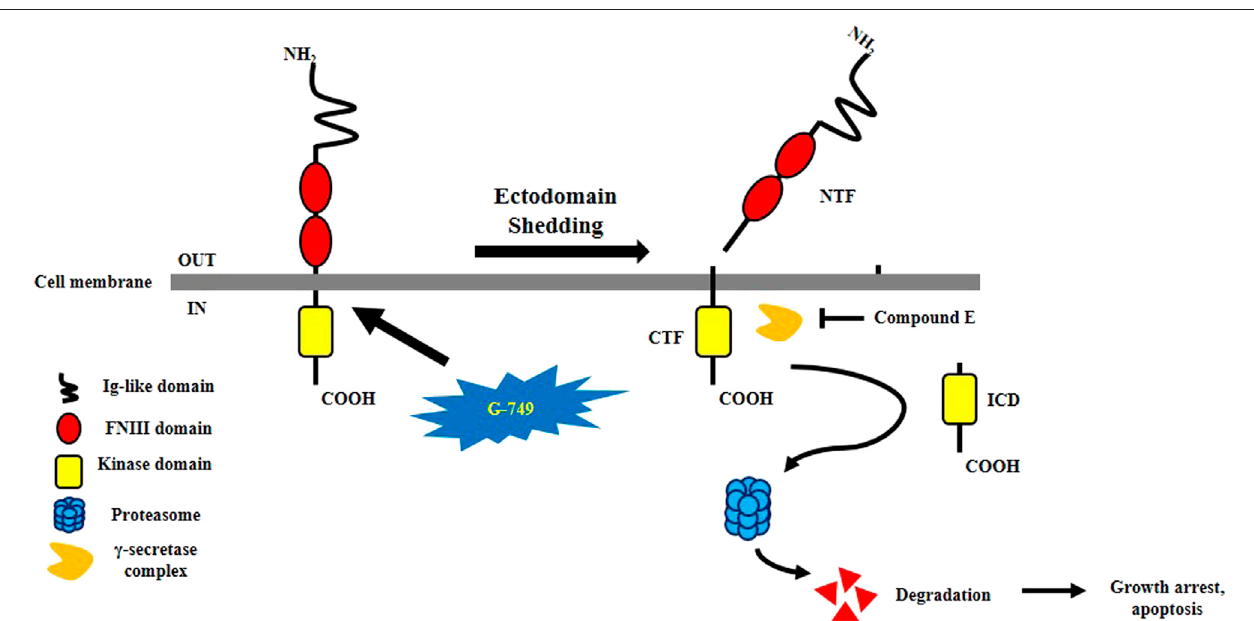
FIGURE 6 | Schematization of G-749-induced TYRO3 degradation. G-749 releases the N-terminal domain of TYRO3. The intracellular C-terminal fragment is released into the cytosol by the γ -secretase complex. Compound E which is a γ -secretase inhibitor, inhibits CTF cleavage. The release of the intracellular domain was accelerated by G-749 and was later degraded via the proteasome pathway. As a result, cell growth is arrested and apoptosis is induced.